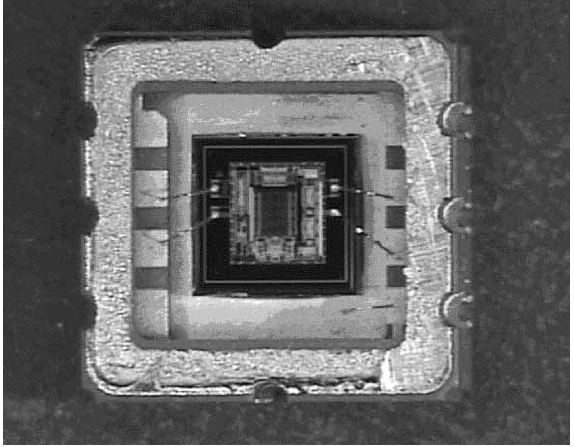
Fig. 4. ADXSTC3-HG sensor die wire bonded to the LCC-8 package.